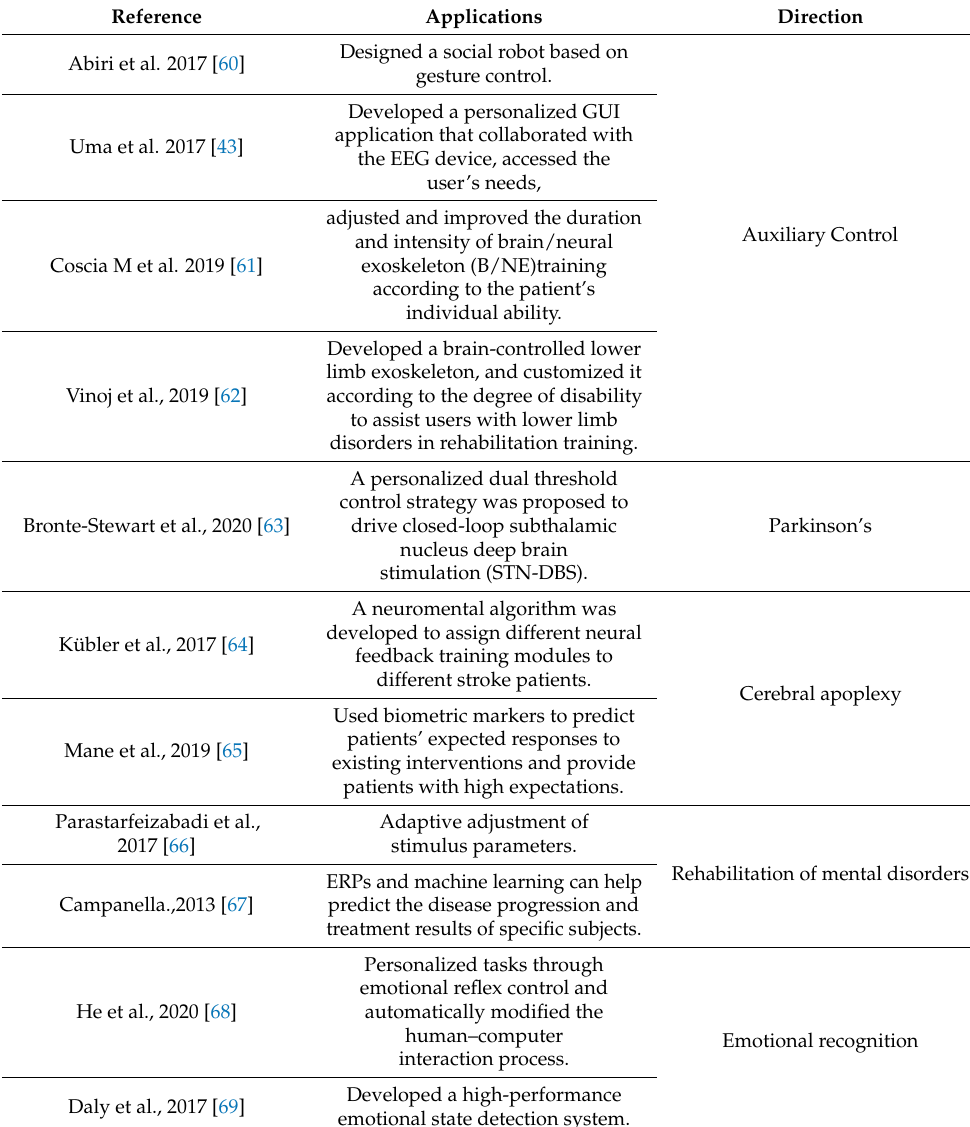
Table 3. Different applications of personalized